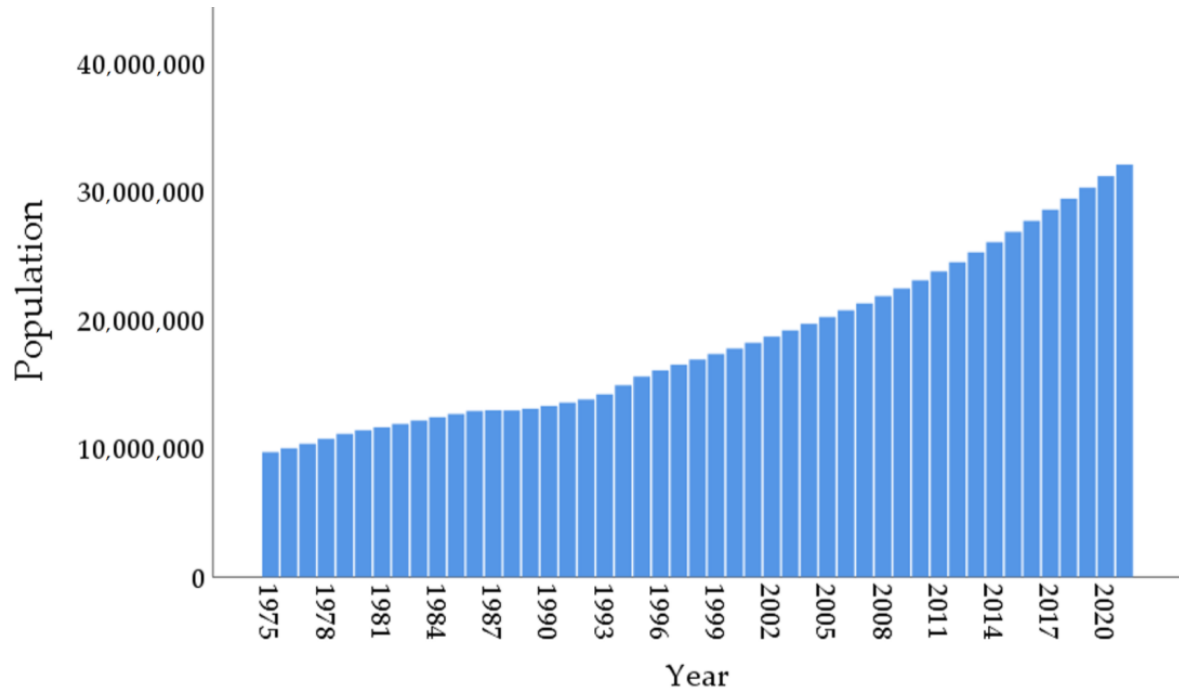
Figure 2. Mozambican population and population growth from 1975 to 2021. Made by the author based on the data from The World Bank Group [48] and World Population Prospects [49] .